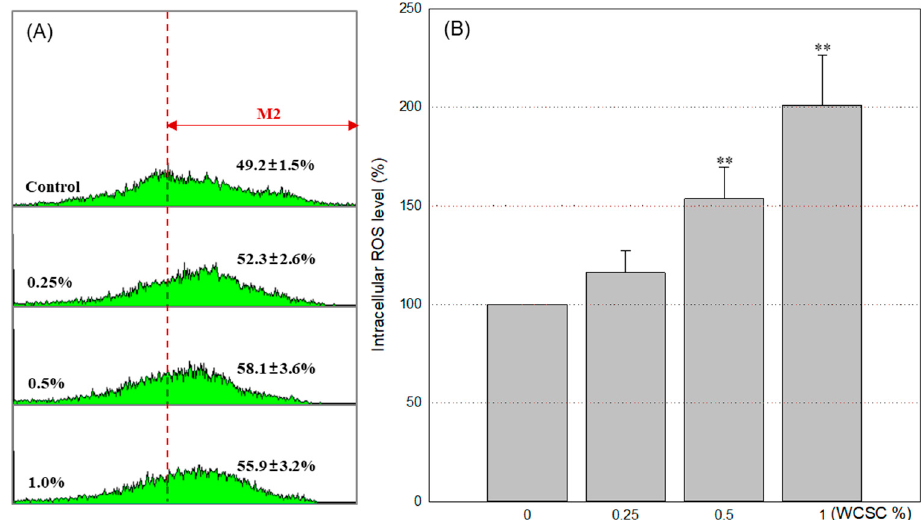
Figure 6. Intracellular ROS generation. Astrocytes were exposed to WCSC in designated concentrations for 24 h and then incubated with H 2 DCFDA for 1 h. Overall, 10,000 cells per sample were analyzed using a FACS system, and the levels were calculated as the relative value, compared to control (100%). Data show mean ± SD of independent three experiments. ** p < 0.01: ( A ) fluorescent intensity in each cell; ( B ) percentages of cells in M2 zone (cells that show increased ROS).